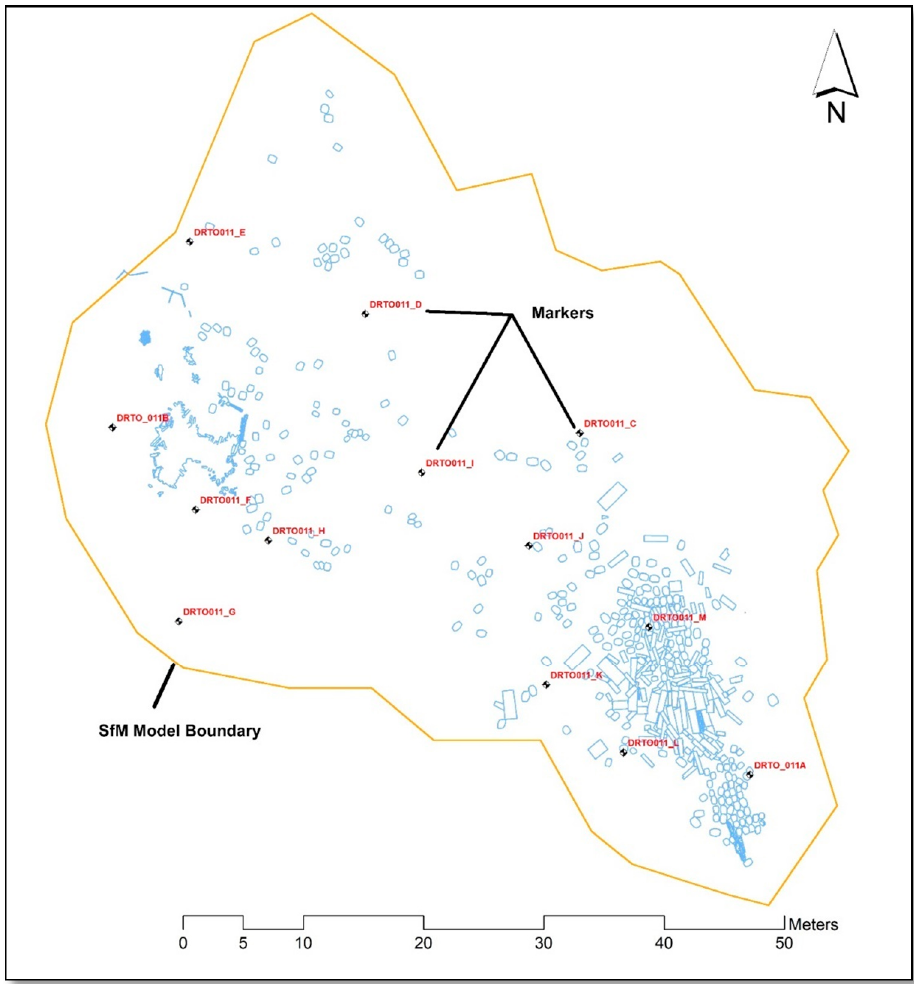
Figure 3. Site plan showing Structure from Motion (SfM) model boundary, Real Time Kinematic (RTK) markers, and NPS hand-mapped site plan from 1990.